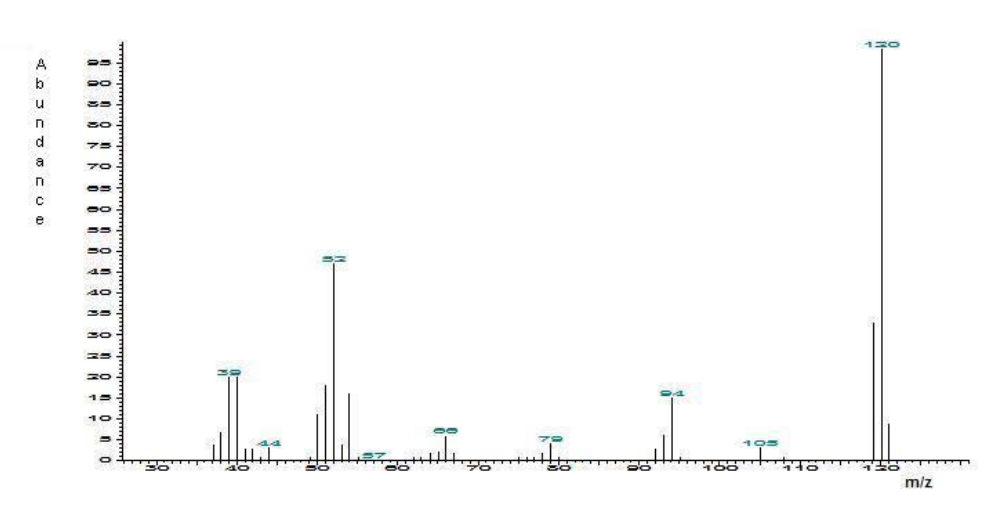
Figure 3. Mass spectrum of